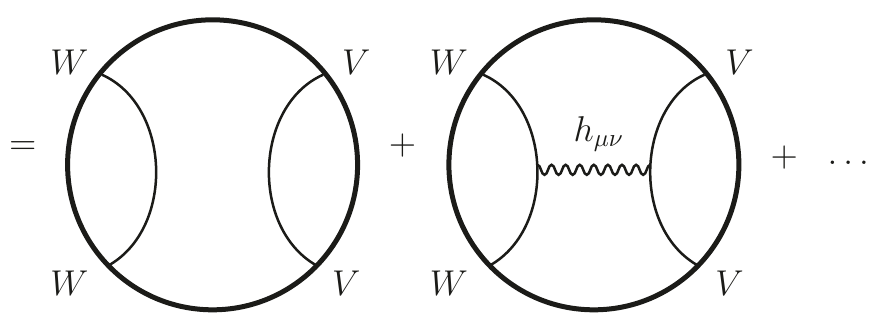
Figure 5 . Disconnected and single-graviton-exchange geodesic Witten diagrams contributing to the